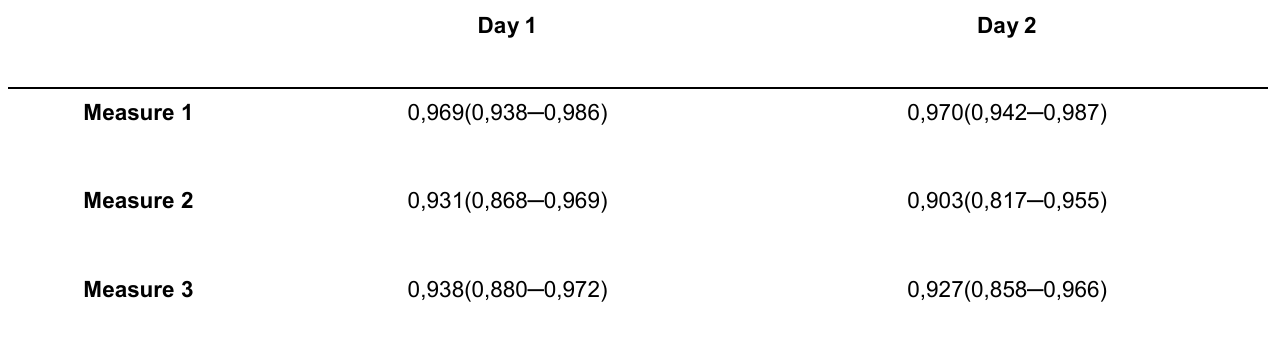
Interrater Reproducibility ─ Intraclass Correlation Coefficient (Confidence